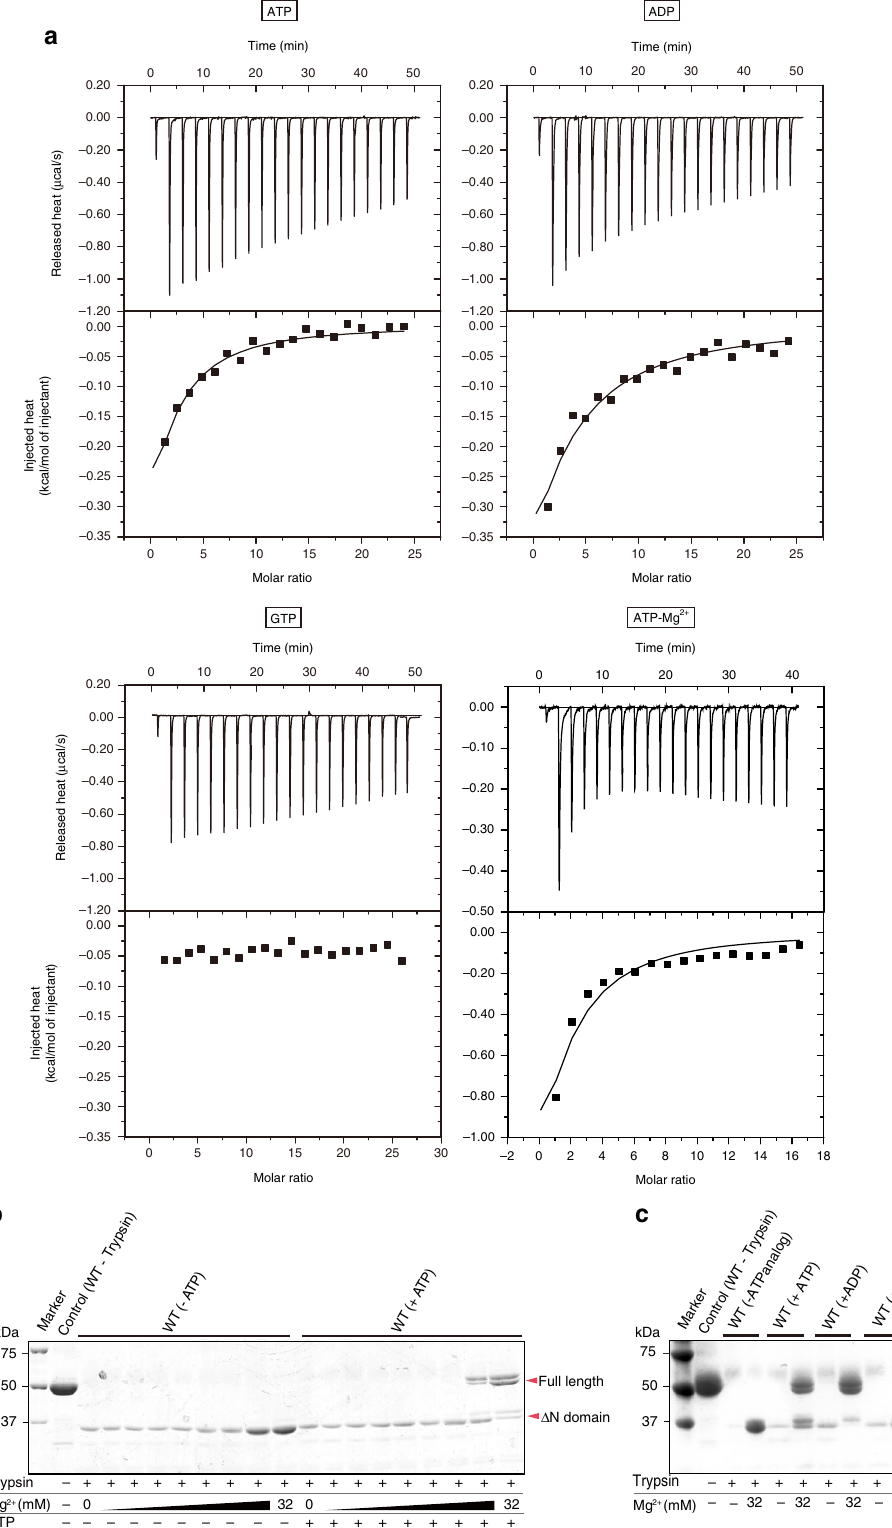
Fig. 1 Effects of ATP and other nucleotides on MgtE. a Isothermal titration calorimetry (ITC) data of MgtE with ATP and other nucleotides. The data were obtained from MgtE with ATP, ADP, GTP, and ATP+Mg 2+ . The raw ITC data and the plots of injected heat for 20 automatic injections of 10 mM nucleotide solution into the sample cell containing the MgtE solution are shown. Measurements were repeated twice, and similar results were obtained. b , c Protease protection of MgtE by Mg 2+ and nucleotides. The numbers on the left side indicate the molecular masses (in kilodaltons) of the markers. The details of the cleavage sites are described in Supplementary Fig.